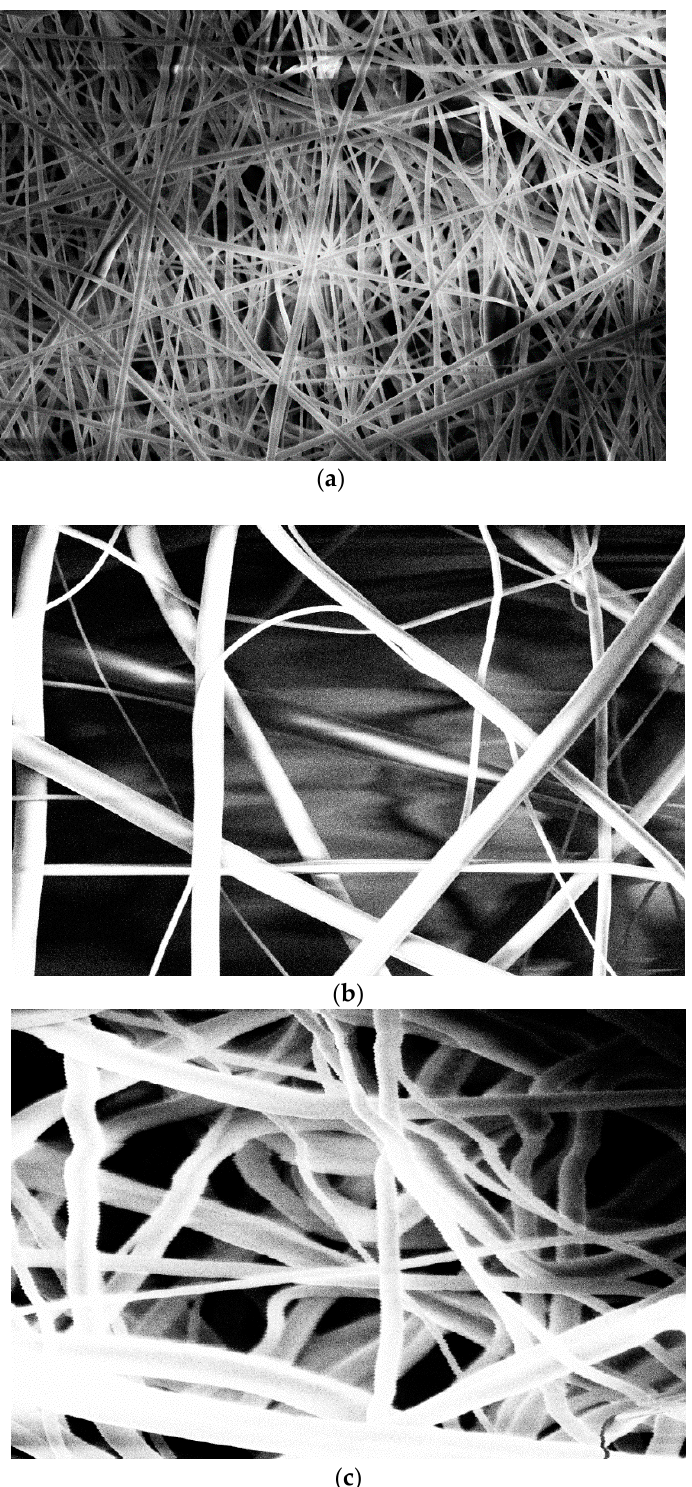
Figure 3. ( a , c , e ) represents FE-SEM images of ( i ) 6, ( ii ) 7 & ( iii ) 8 wt.% of PVP/TiO 2 nanofibers and ( b , d , f )represent their corresponding diameter histograms.